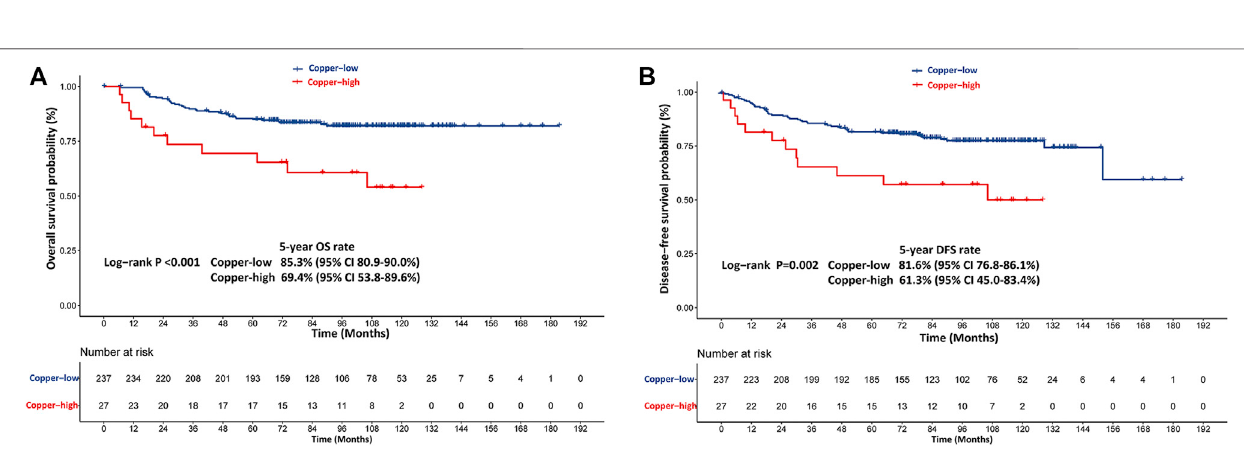
Frontiers in Cell and Developmental Biology |